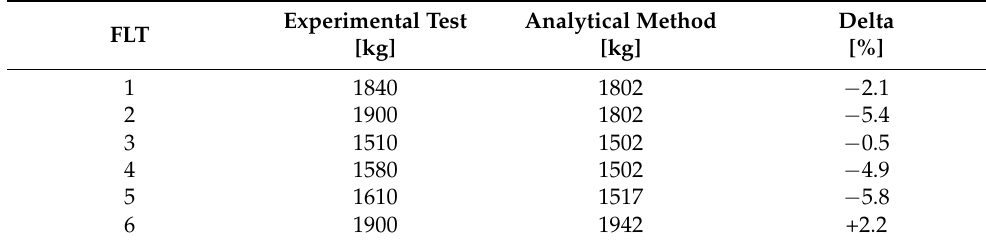
Table 2. Comparison between experimental tests and analytical procedure for clamp with parallel arms.